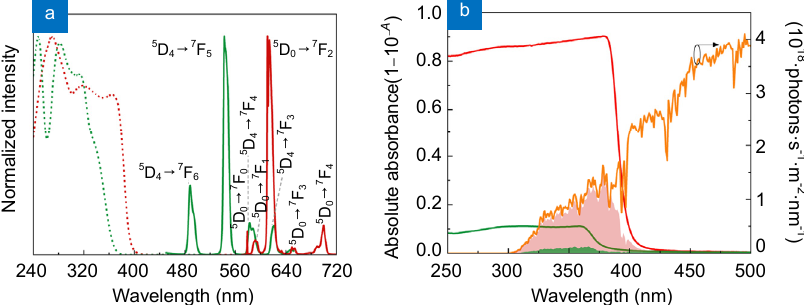
Fig. 2 | ( a ) Excitation spectra (dashed lines) monitored at 543 nm and 615 nm for dU6-Tb (green line) and tU5-Eu (red line), respectively, and emission spectra (solid lines) excited at 315 nm for dU6-Tb (green line), and 365 nm for tU5-Eu (red line); ( b ) Absorption spectra of dU6-Tb and tU5-Eu and AM1.5G photon flux (right y axis). The shadowed areas represent the overlap integral, Eq. (3), with the same colour code as the excitation and emission